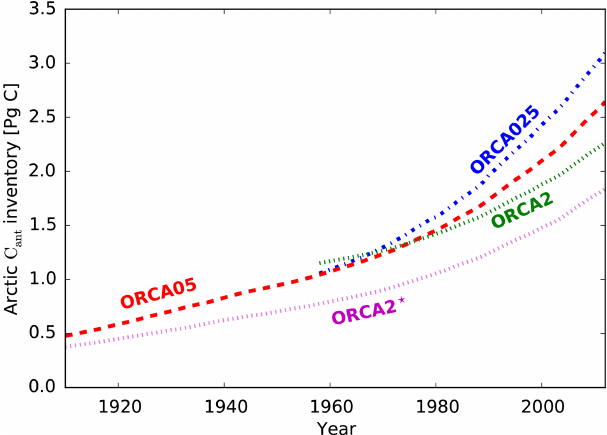
Figure 2. Arctic Ocean C ant inventory for ORCA2, ORCA05, ORCA025, and ORCA2 ∗ . The discontinuity for ORCA2 in 1958 is due to its larger total volume of water when integrated across the Arctic domain (Table